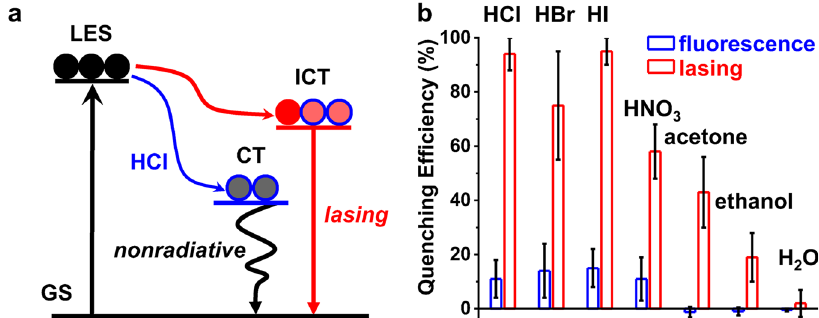
Fig. 5 Enhanced sensing properties of BPCBT microwires to chemical vapors. a Mechanism of lasing sensor based on the competition between nonradiative transition of charge transfer (CT) to HCl and radiative ICT transition of BPCBT. b Quenching ef fi ciencies of photoluminescence and lasing from BPCBT microwires upon exposure to chemical vapors of HCl, HBr, HI, HNO 3 , acetone, ethanol, and water, respectively. Error bars represent the deviation of three